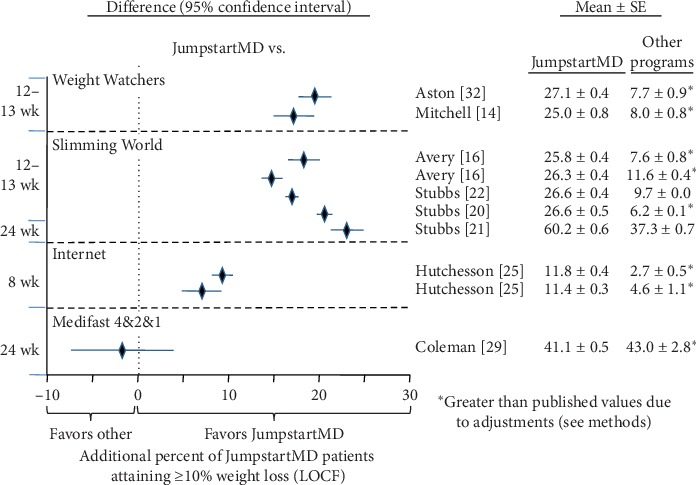
Mean LOCF weight loss difference between JumpstartMD and other commercial programs as measured by percent attaining ≥10% weight loss. Positive differences designate greater JumpstartMD weight loss. See legend to Figure 5 for further explanation.